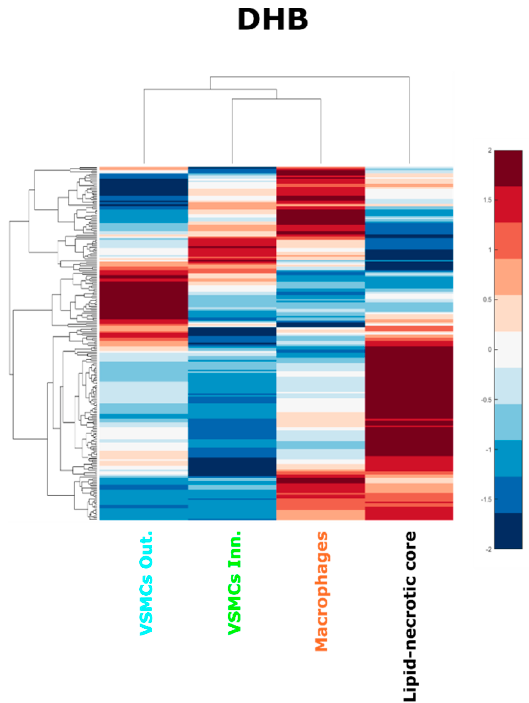
Figure 6. Hierarchical cluster analysis of the lipid-necrotic core, outer VSMC, inner VSMC and macrophage regions. Average spectra of the regions were used to perform a hierarchical cluster analysis for the DHB dataset.